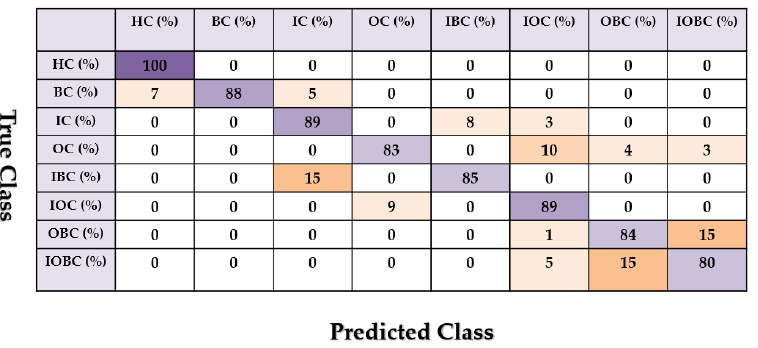
Figure 12. RMS of the resampled AE residual signals for crack type diagnosis in normal and abnormal conditions using the proposed digital twin (PDT). Figures 13–15 show the confusion matrix for the combined ALSGL-SB and SVM, combined ALSGL-SBI and SVM and combined PDT and SVM for crack type diagnosis, respectively.